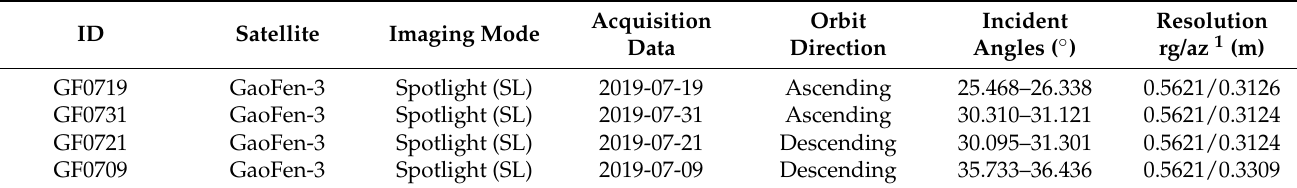
Table 1. Basic parameters of stereo